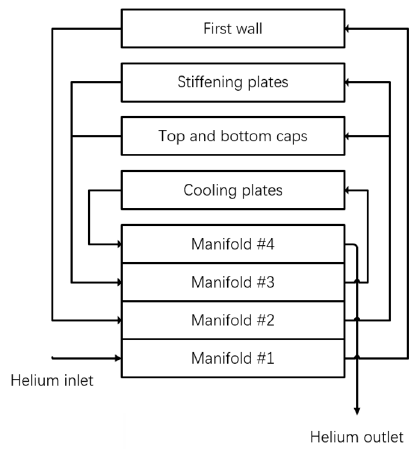
Figure 7. Flow scheme of the helium coolant.